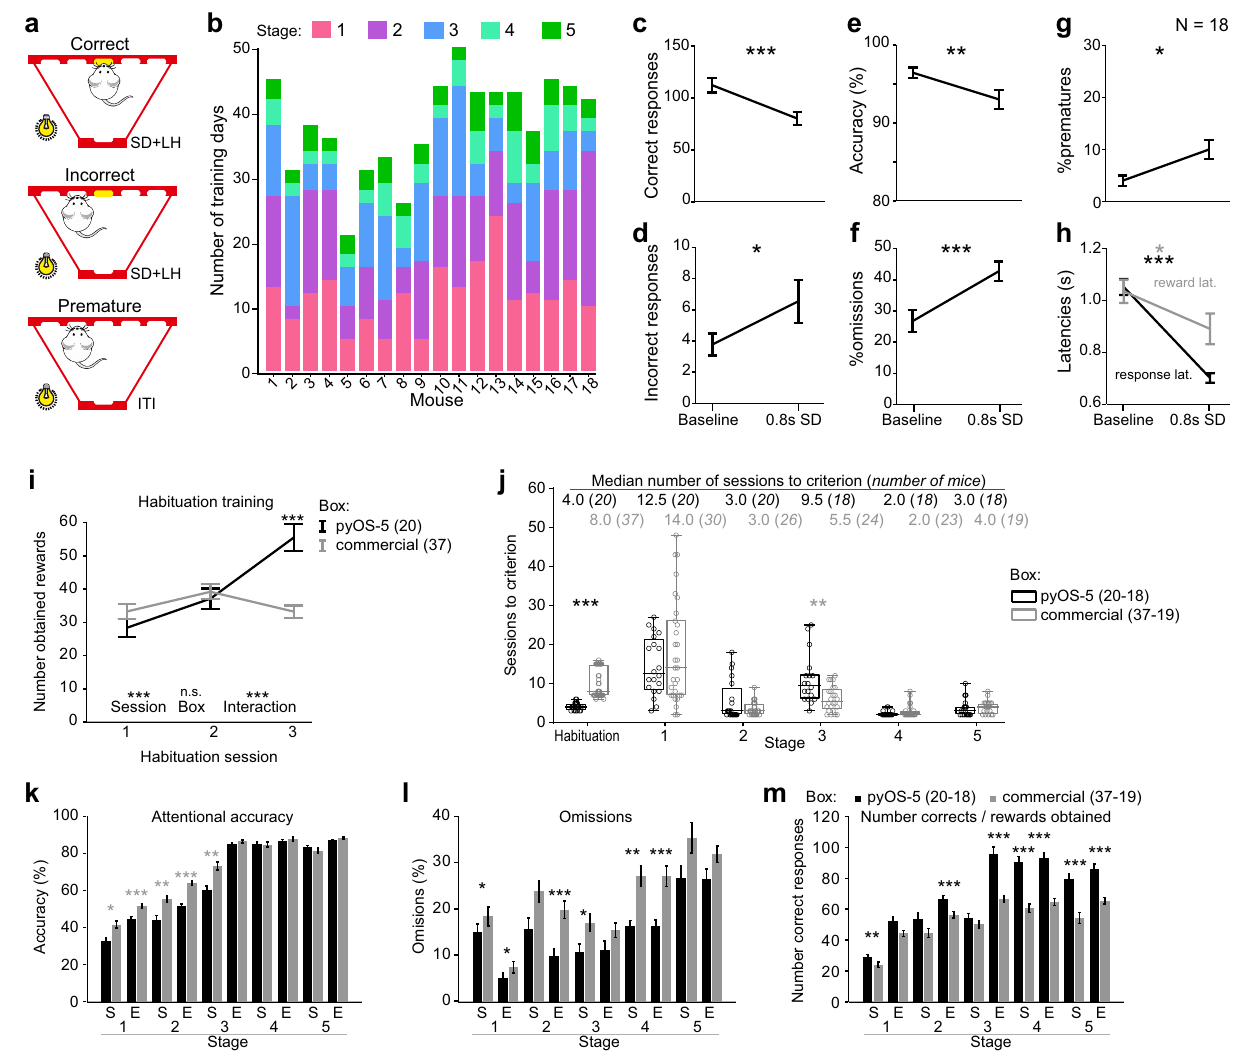
Figure 5. 5-CSRTT training and performance. ( a ) Three principal response types of the 5-CSRTT, as indicated. Schemes were drawn in CorelDraw Graphics Suite 2021 (https:// www. corel draw. com). ( b ) Number of training sessions needed by each of the 18 mice in the cohort to transition through the 5 training stages (colour-coded) from the first training day with 65 lx poke-hole illumination (day 14 on stage 1; see Supplementary Fig. 3) until reaching of criterion on stage 5. ( c–h ) 5-CSRTT performance during the final training stage (5, baseline) and an attention challenge (0.8 s SD); shown are indicators of sustained attention and task participation, namely total number of correct (c) and incorrect (d) responses (c) , their ratio (accuracy, e ), relative omission rates (f) ; an indicator of motor impulsivity (relative number of premature responses, g ); and reward (black) and response (grey) latencies (h) . Lines display mean ± s.e.m. Asterisks in (c–h) indicate significant within- subject comparisons relative to the baseline (2 s SD, 5 s ITI) with paired-samples t -tests. ( i ) Number of rewards obtained in the first 3 sessions of habituation training; assessment at bottom reflects RM-ANOVA. ( j ) Number of sessions needed to reach criterion on each training stage shown for individual animals and as box-plots for the whole group, median number for each group (black, pyOS-5; grey, commercial system) stated on top with contributing N -numbers in brackets; N vary because not all animals were trained continuously to stage 5. ( k–m ) Key performance parameters that determine stage transitions, named above each panel, are displayed as mean ± s.e.m. across animals. Each contributing data point was calculated as average of the first two (S) or last two (E) days an animal was trained on the indicated stage. Asterisks above data in (i ), ( j) , ( k–m ) indicate Sidak post-hoc, MWU, and Bonferroni-adjusted t -tests, respectively. Asterisks in black indicate that mice trained in pyOS-5 outperform mice trained in the commercial box. * P < 0.05, ** P < 0.01, *** P <